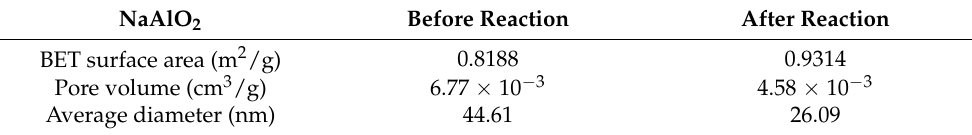
Figure 3. The nitrogen adsorption–desorption isotherms of NaAlO 2 before ( a ) and after ( b ) the catalytic reforming process. Table 1. BET characterization of NaAlO 2 before and after